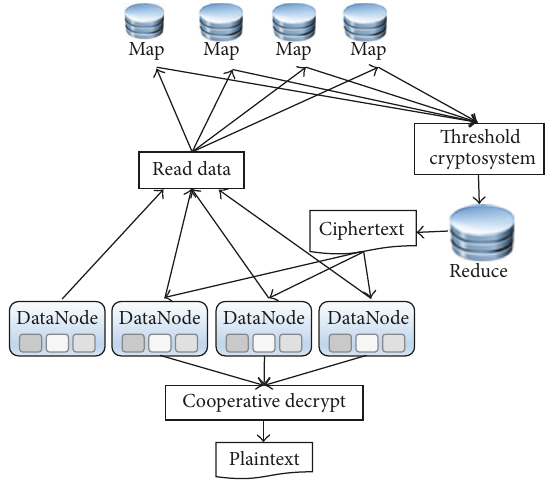
Figure 3: Privacy computing efficiency iteration results of all